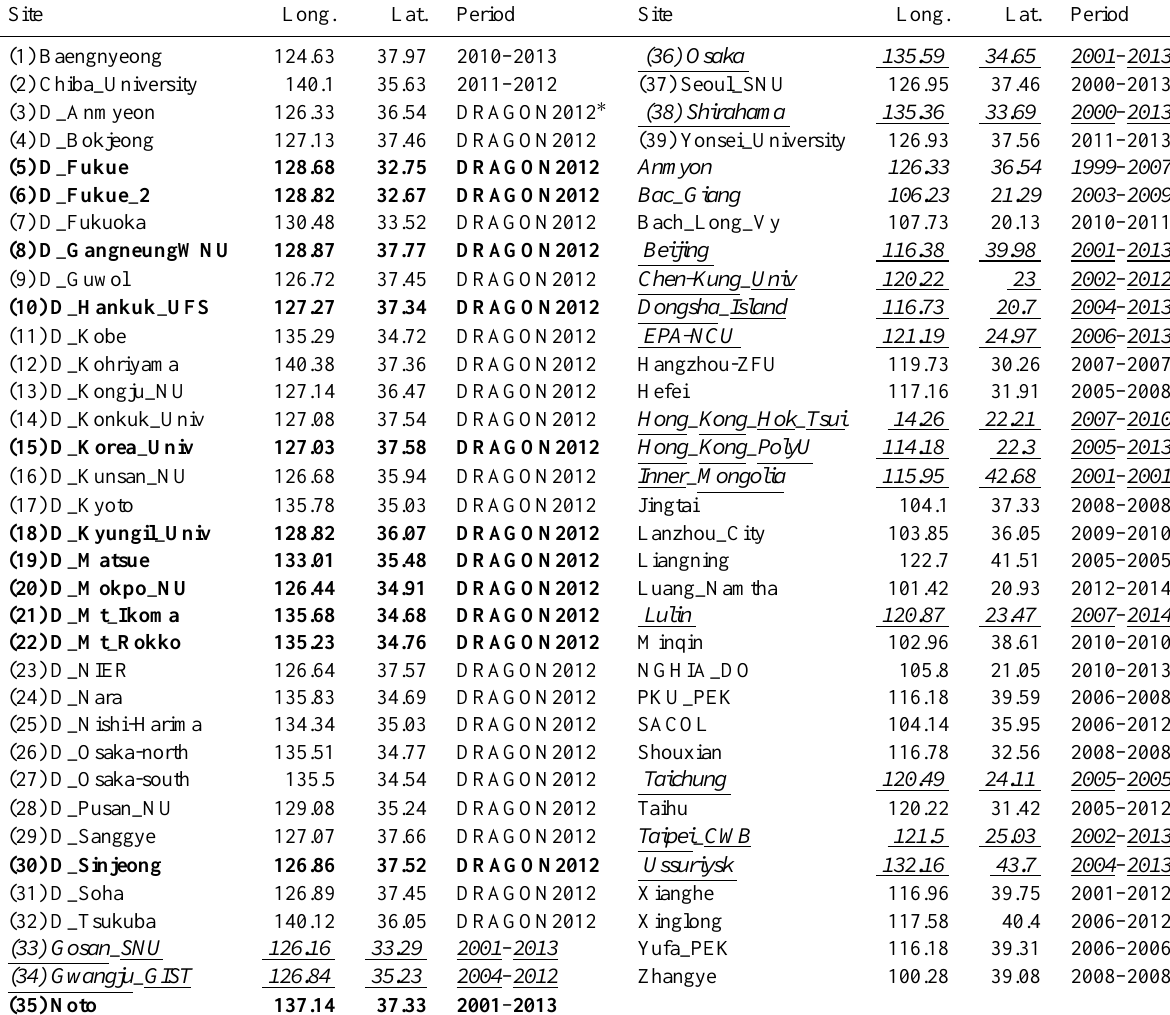
Table 1. Summary of AERONET sites used in this study. The “Period” column represents the retrieval period of the daily inversion product (level 2.0), and the longitude (long., ◦ E) and latitude (lat., ◦ N) show the location for each site. The number before the site name lists the sites operated for the DRAGON-Asia campaign, where “D” is the initial of the campaign. The numbers are linked to Tables 3, 4, and Fig. 10. The type of character categorizes the inversion data set into the “original”, “new”, and “excepted” groups. While the “original” group is compiled from the inversion data sets obtained before 2011 at sites in italic type, the “new” group consists of the total data set excluding the “excepted” group shown in bold